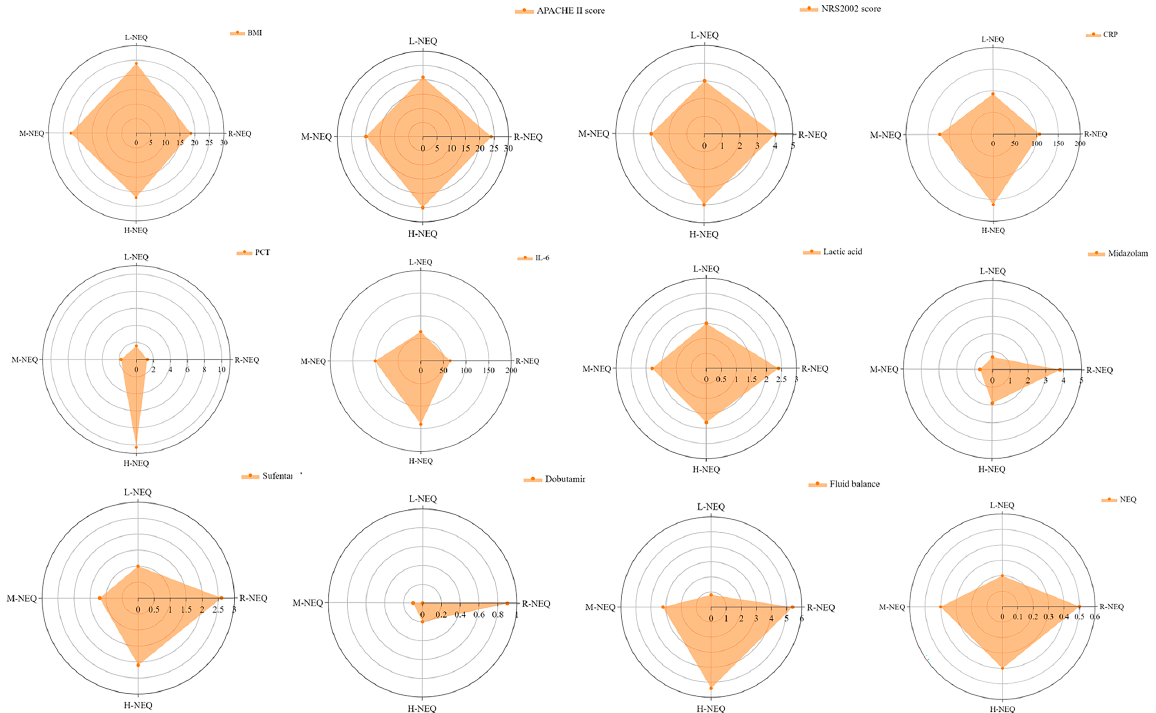
Figure 3. Radar charts of patient characteristics in the four groups. APACHE II, Acute Physiology and Chronic Health Evaluation II; BMI, body mass index; NRS2002, Nutritional Risk Screening 2002; CRP, C-reactive protein; NEQ, norepinephrine equivalent dose; PCT, procalcitonin; L-NEQ, low-dose stable NEQ; M-NEQ, moderate-dose stable NEQ; H-NEQ, high-dose stable NEQ; R-NEQ, rapidly rising NEQ.